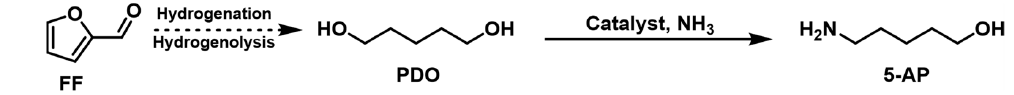
3 to synthesize